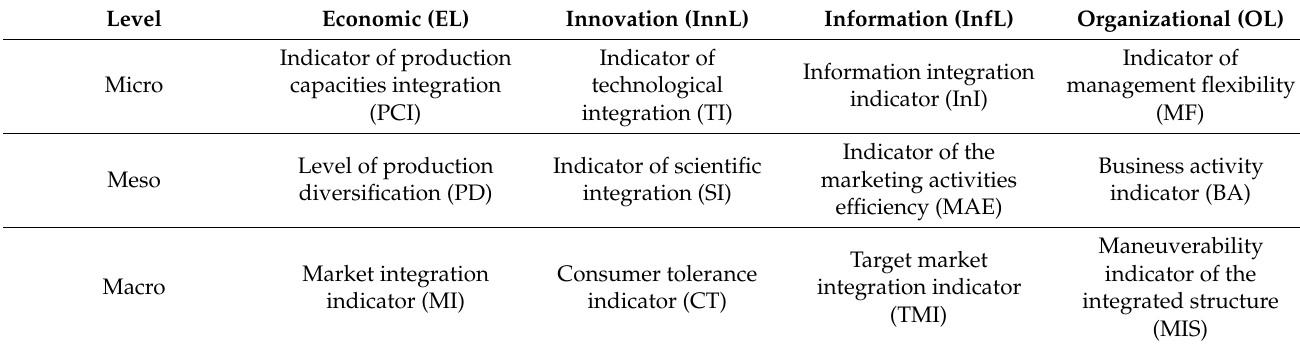
Table 2. Matrix of the integrated development of the company